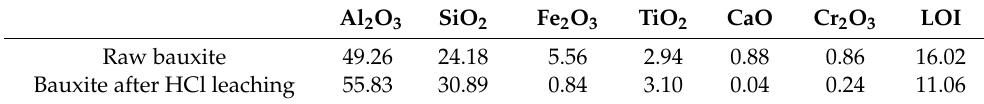
Table 1. Chemical composition [wt. %] of the Severoonezhsk bauxite before and after HCl